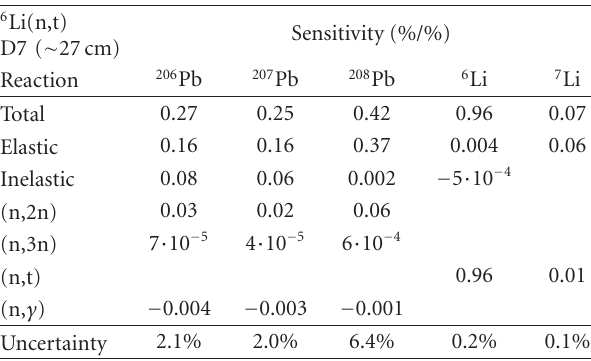
Table 4: Sensitivity of the TPR to cross-sections for the detector position D7 (SUSD3D results based on the TORT 3D neutron fluxes).